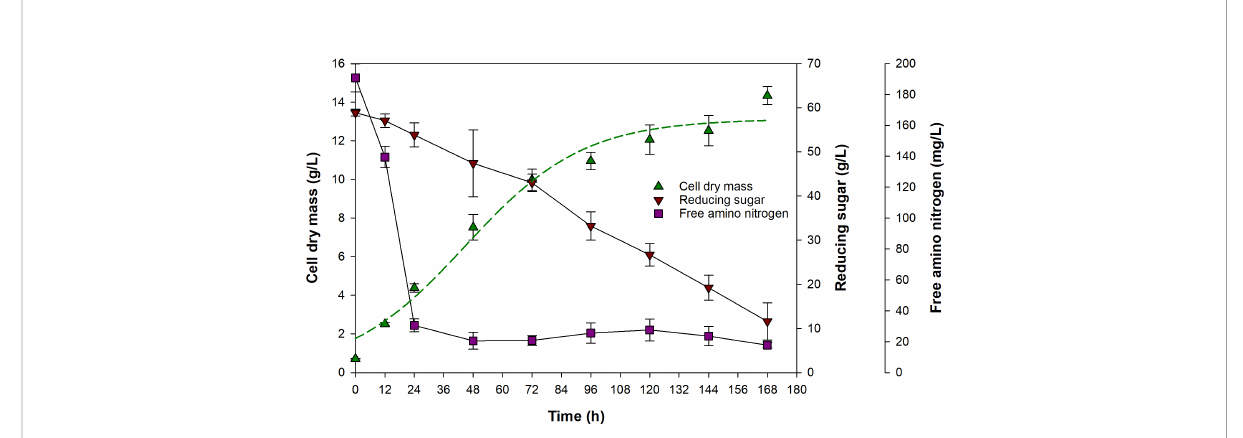
FIGURE 4 Growth and substrates consumption of A. limacinum SR21 during a cultivation under the optimum conditions. Dashed line represents data predicted by Eq. (3).